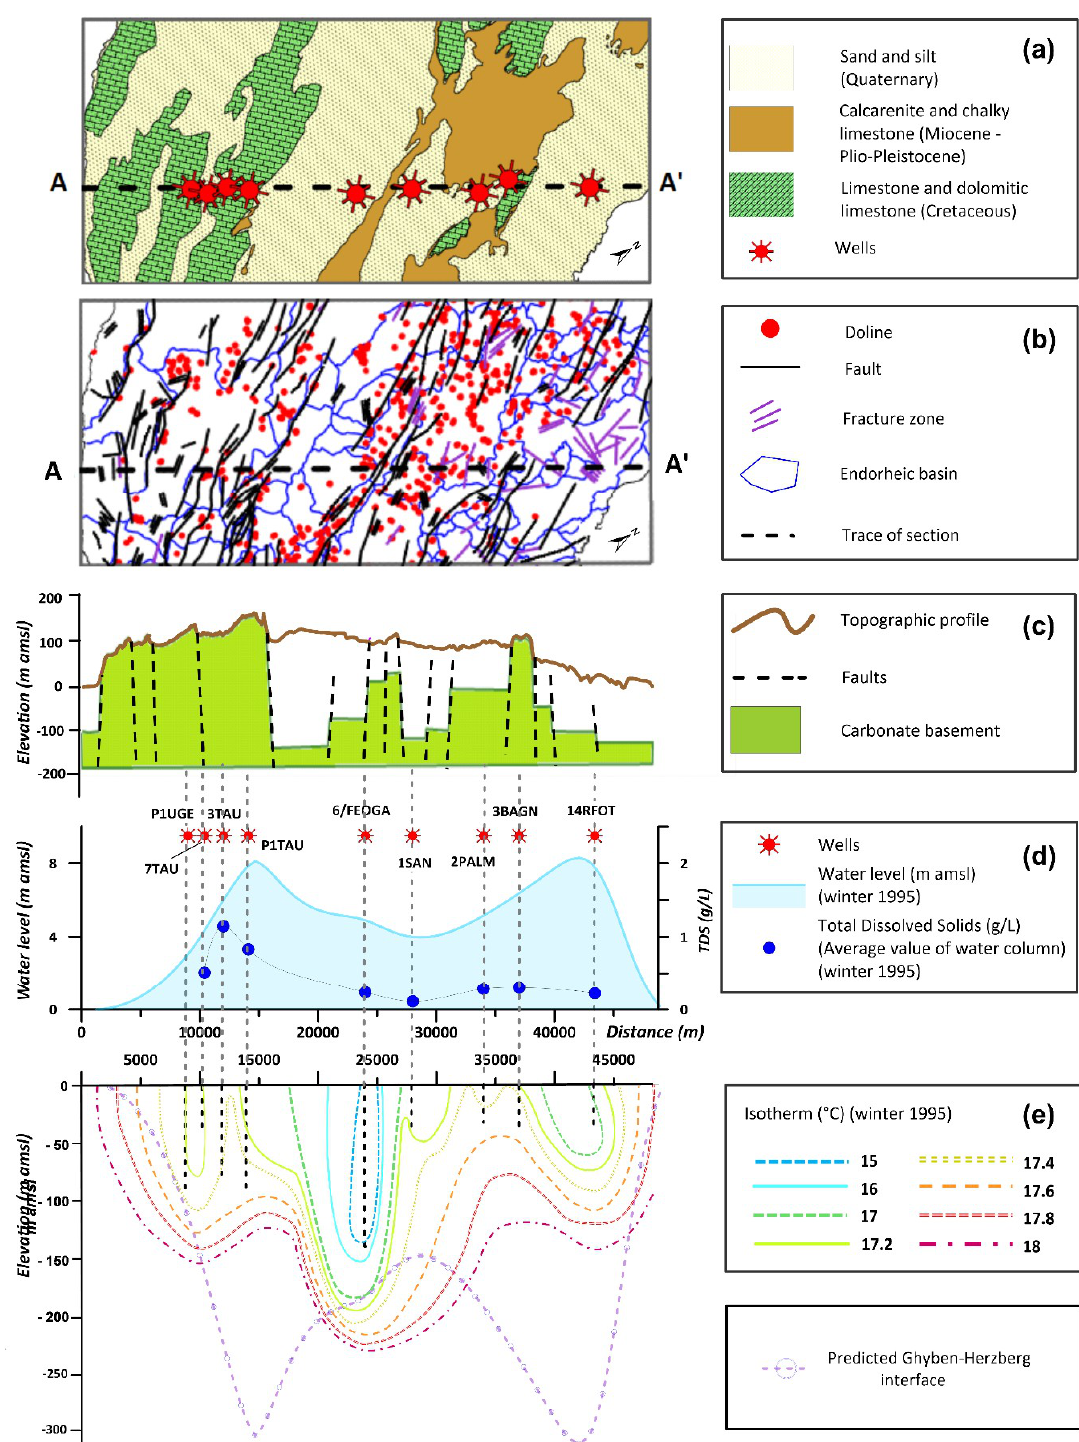
Figure 4. Geological, geomorphological, hydrogeological and thermal outline of an area of Salento Peninsula (borders in Figure 3a): ( a ) simplified lithological map, track of section AA’, and wells; ( b ) macro endorheic basins, dolines, and tectonic lineaments; ( c ) schematic geological cross section along track AA’ showing the elevation of the top of the carbonate basement and the normal faults; ( d ) water level profile, with location (dotted lines) and codes of wells used for ( e ), average TDS of water columns of the same wells; ( e ) thermal cross-section, penetration (vertical dotted lines) of wells and predicted Ghyben-Herzberg interface.